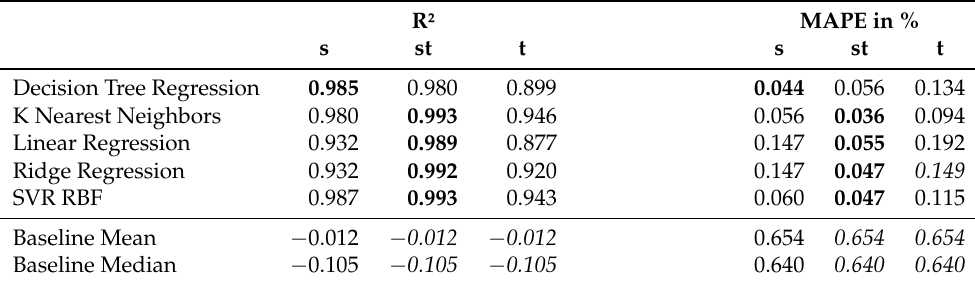
Table 6. Stacking Box Data Set I: results for Target Weight. The differences in comparisons of st or t vs. s were tested for significance, using the Wilcoxon signed-rank test ( α = 0.05). Where the test did not confirm significant differences, the respective st or t values are printed in italic. The highest R 2 and the lowest MAPE are shown in bold for each algorithm. R² MAPE in % s st st Decision Tree Regression